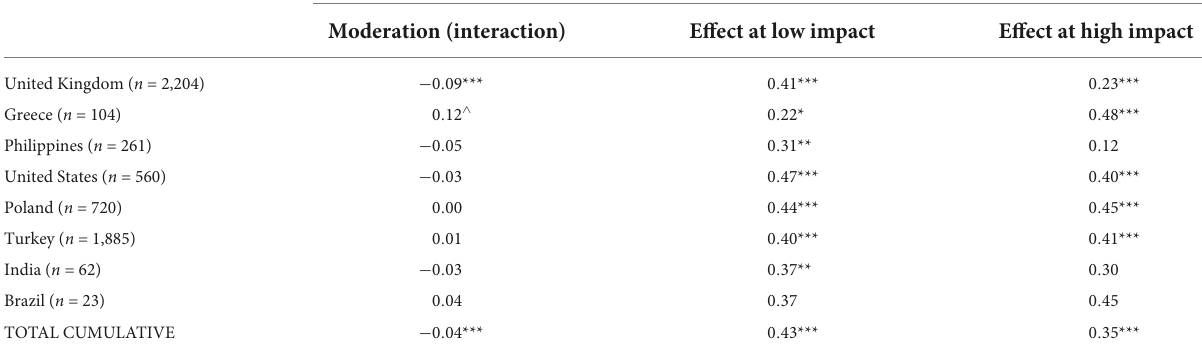
TABLE 12 Moderating impact of experiences/impacts on the relationship between political beliefs and perceived threat. Nation Measure Moderation (interaction) Effect at low impact Effect at high